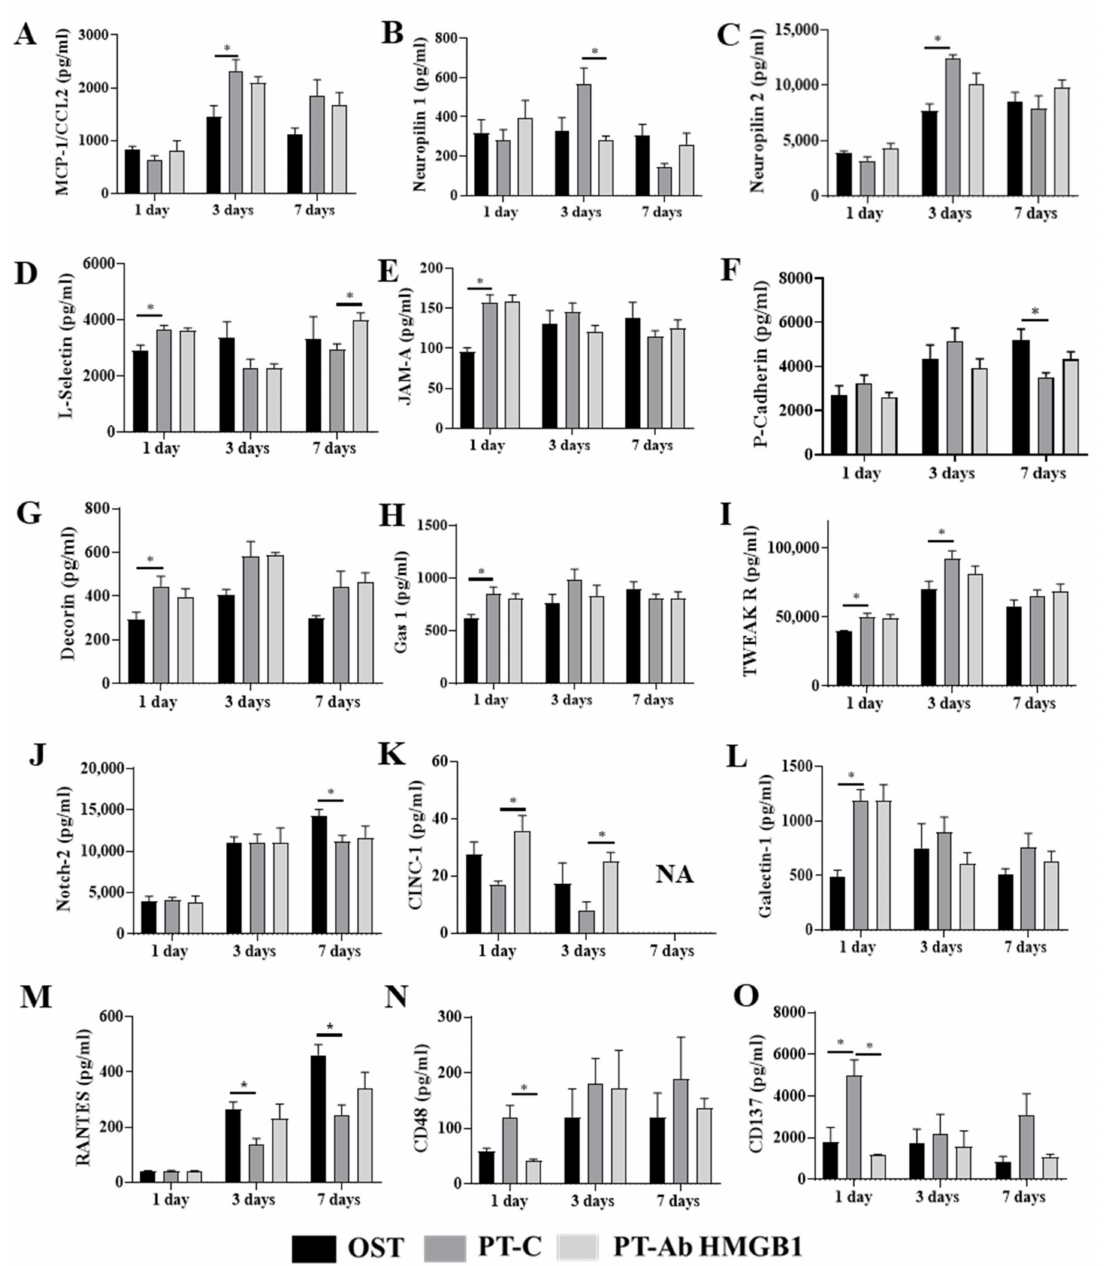
Figure 2. Plasma samples from osteotomy (OST), polytrauma (PT-C), and polytrauma + anti-HMGB1 antibody (PT-Ab HMGB1) at 1, 3 and 7 days post-trauma (dpt) were quantitatively assessed for cytokine protein expression. ( A ) Monocyte attracting chemokine (MCP-1/CCL2); ( B ) Neuropilin 1; ( C ) Neuropilin 2; ( D – F ) Adhesion molecules: L-selectin, junctional adhesion molecule (JAM-A) and P-cadherin, respectively; ( G ) Proteoglycan: decorin; ( H ) Cell arrest and apoptosis regulator (GAS-1); ( I ) TNF-related weak inducer of apoptosis receptor (TWEAK R); ( J ) Neurogenic locus notch homolog protein 2 (Notch 2); ( K ) Cytokine-induced neutrophil chemoattractant 1 (CINC-1); ( L ) Anti-inflammatory and T cell suppressive protein: Galectin 1; ( M ) Regulated on activation, normal T cell expressed and secreted (RANTES); ( N ) Lymphocyte activation marker: CD48; and ( O ) lymphocyte activation co-stimulatory immune checkpoint molecule: CD137. ( n = 4–5 for OST, PT and PT-Ab HMGB1) * p < 0.05 comparing OST and PT-Ab HMGB1 rats to PT-C rats. The bar graphs represent the mean, whereas error bars represent SEM. NA–protein expression data is not